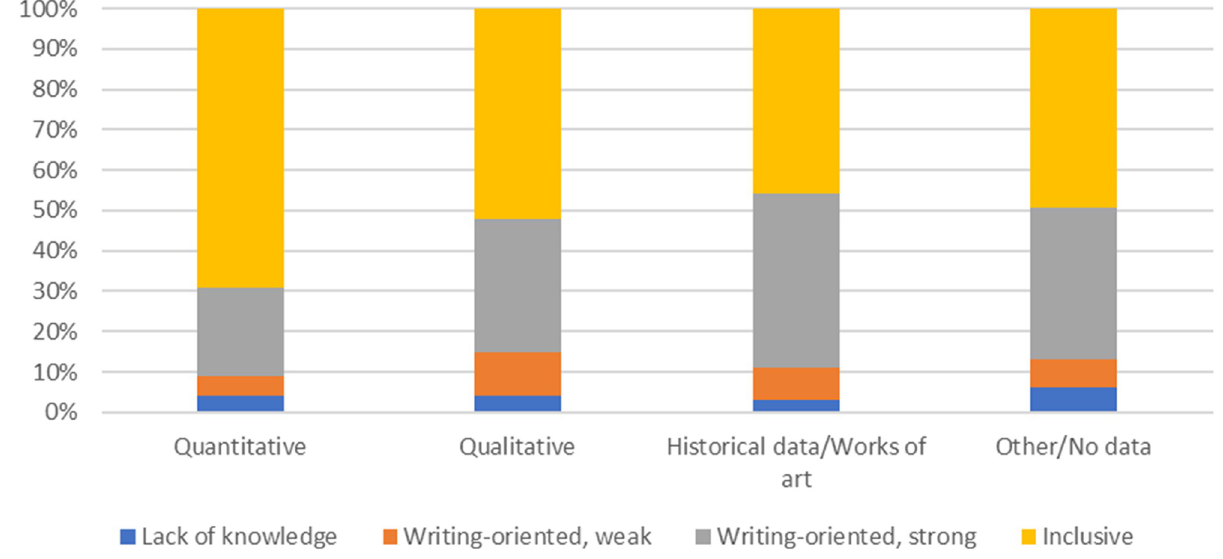
Fig 2. Distribution of the four views on authorship across datatypes (shares based on predicted probabilities).